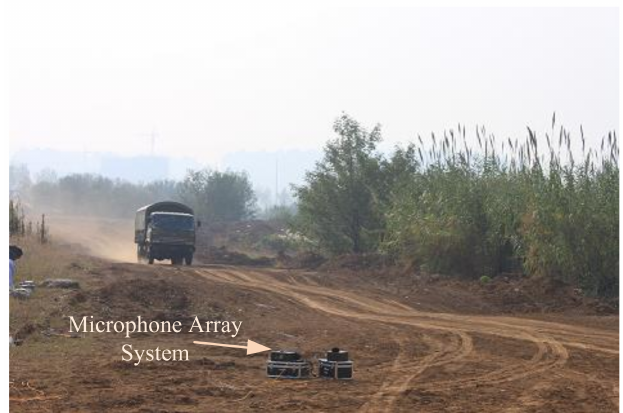
Figure 7. Photograph of the experimental environment.